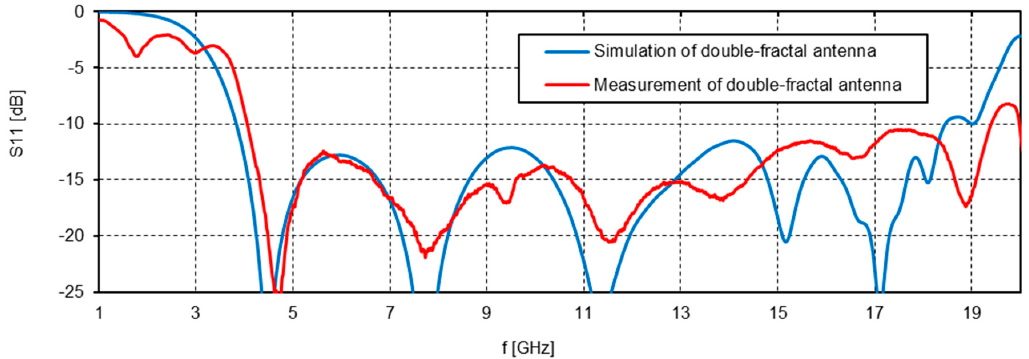
Figure 7. Results of simulated and measured values of S11 for the double-fractal antenna.